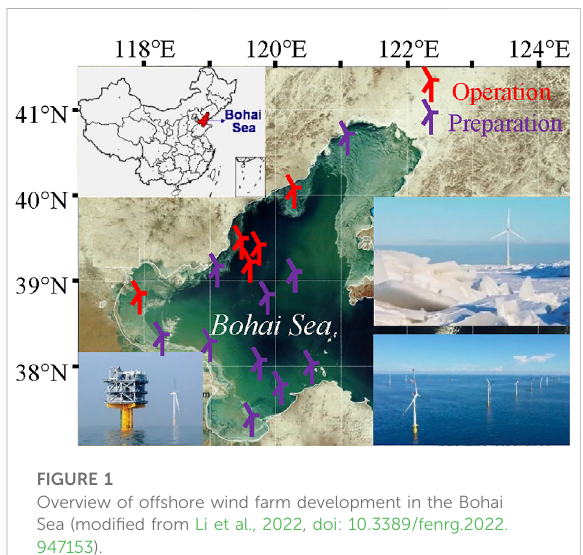
FIGURE 1 Overview of offshore wind farm development in the Bohai Sea (modi fi ed from Li et al., 2022, doi: 10.3389/fenrg.2022. 947153).